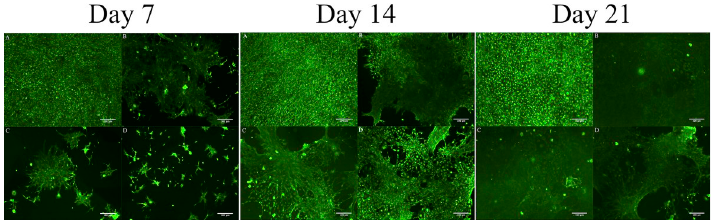
Fig 7. The live/dead staining images of (A) control (2D culture), (B) mPA, (C) H5/mPA, and (D) M10/mPA after day 7, 14, and 21 cultured. (B, C, D were 3D